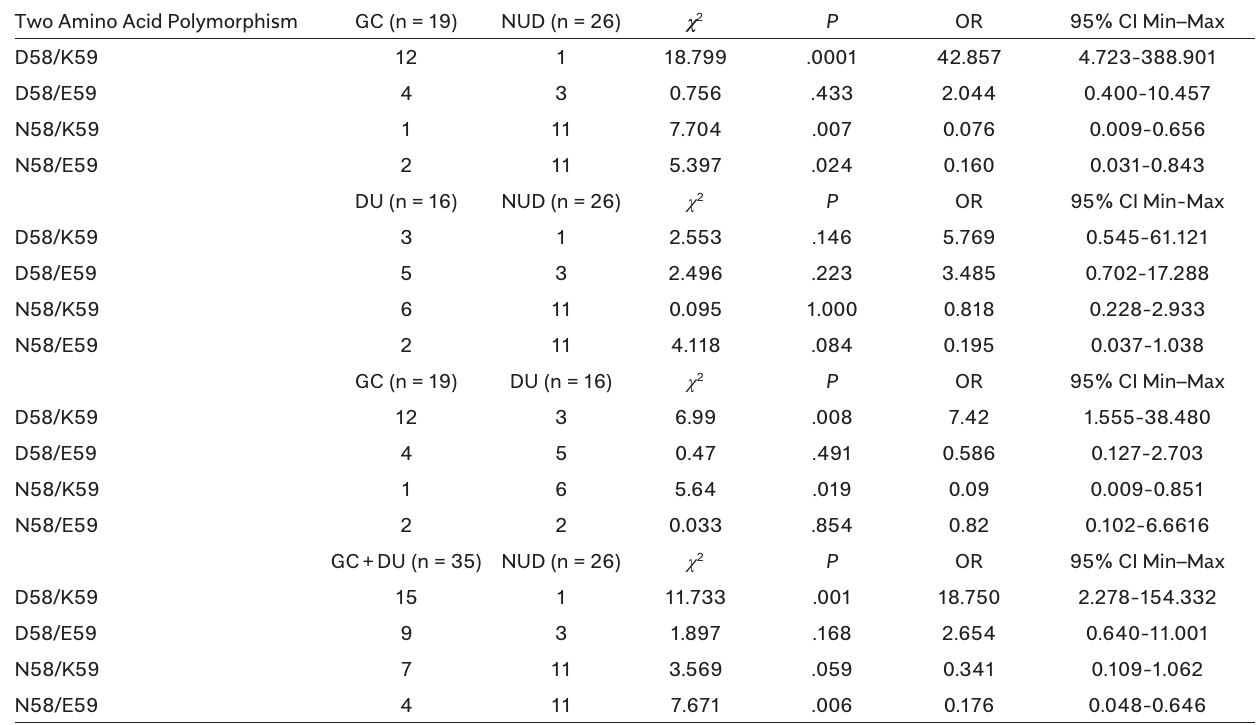
Table 4. The Comparison of the Study and Control Cases in Terms of Polymorphisms Containing the 58th and 59th Amino Acid Polymorphisms Detected in the cagLHM Region